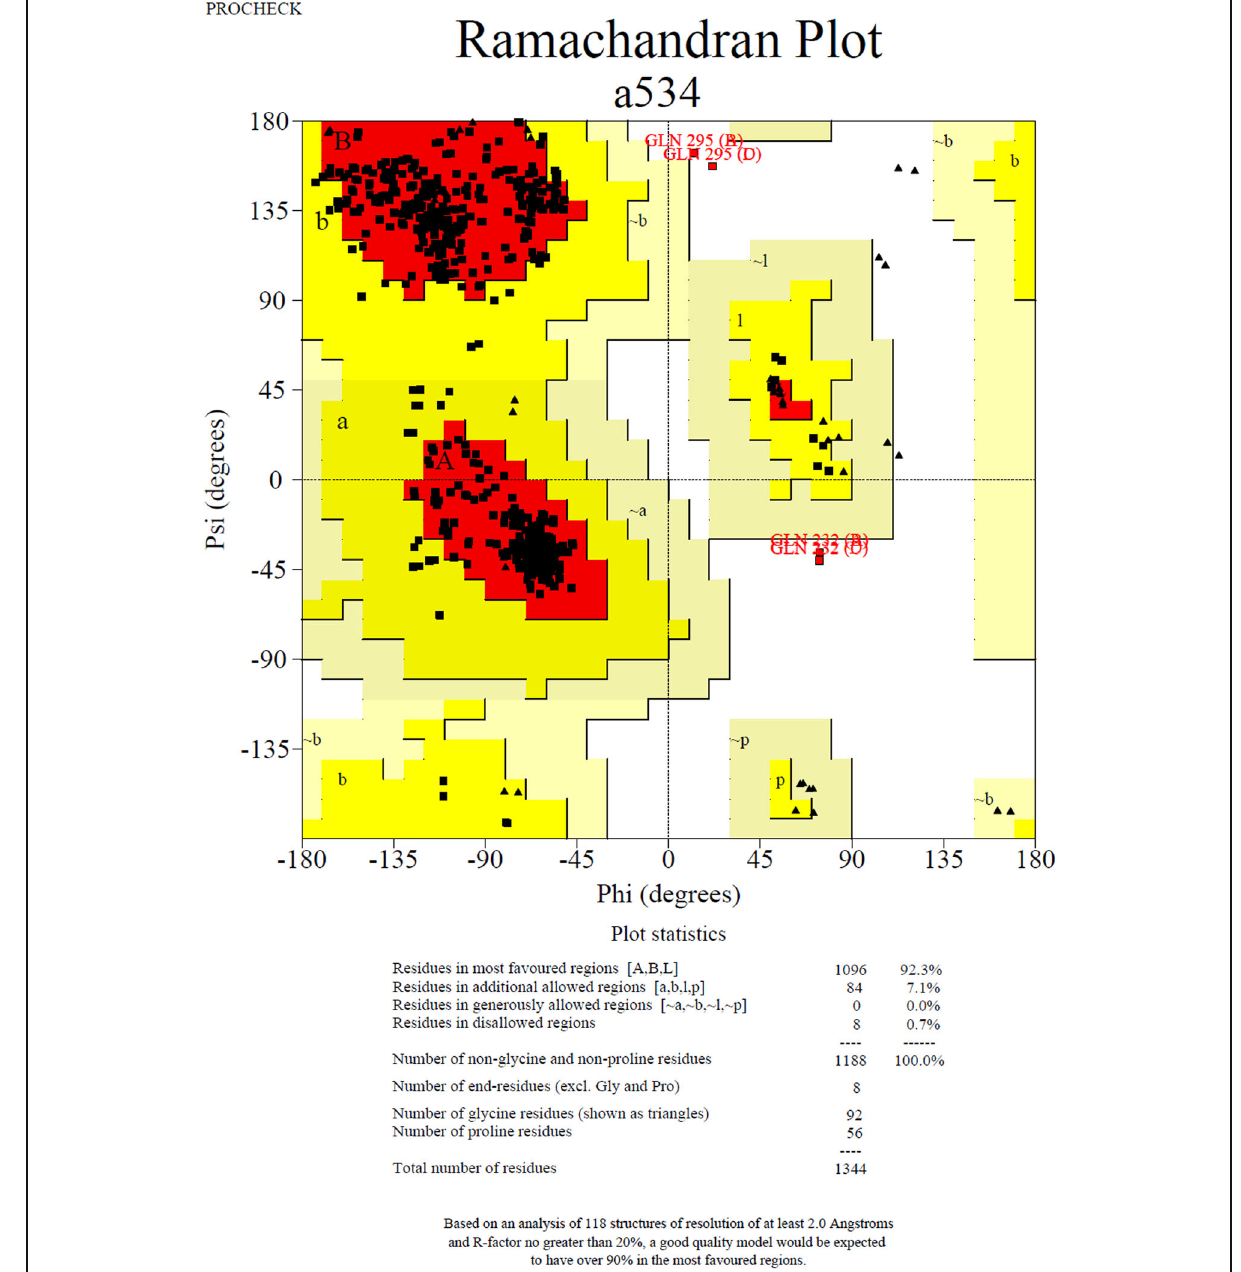
Fig. 4 Ramachandran plot for EJJ83173 protein. The plot was constructed using PROCHECK in the PDBsum database to ascertain the protein stability and model quality. One thousand ninety-four residues (92.3%) are found in the most favored region, proving a good model